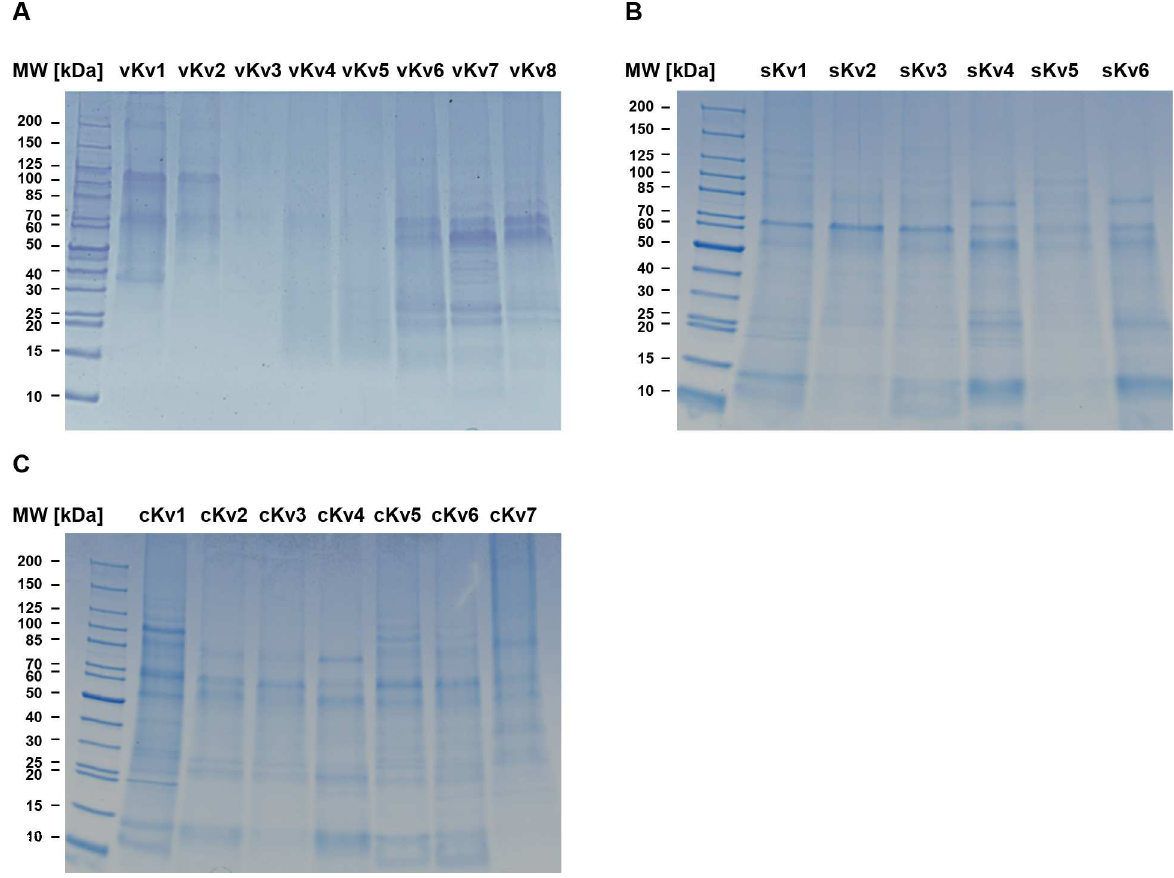
Fig 2. Images of colloidal Coomassie Blue stained1D-SDS-PAGE gels loadedwith biological replicates of historical diagnostically in vivo validatedKv (vKv) (Fig 2a), newly created Kv from sarcoidosis spleen(sKv) (Fig 2b) and newly created control Kv from healthy spleentissue (cKv) (Fig 2c). Each lane was sliced into 10 equal sections. Proteins were subjectedto in-gel tryptic digestionand peptides analysedby MS/MS and databasesearchingfor protein identification.